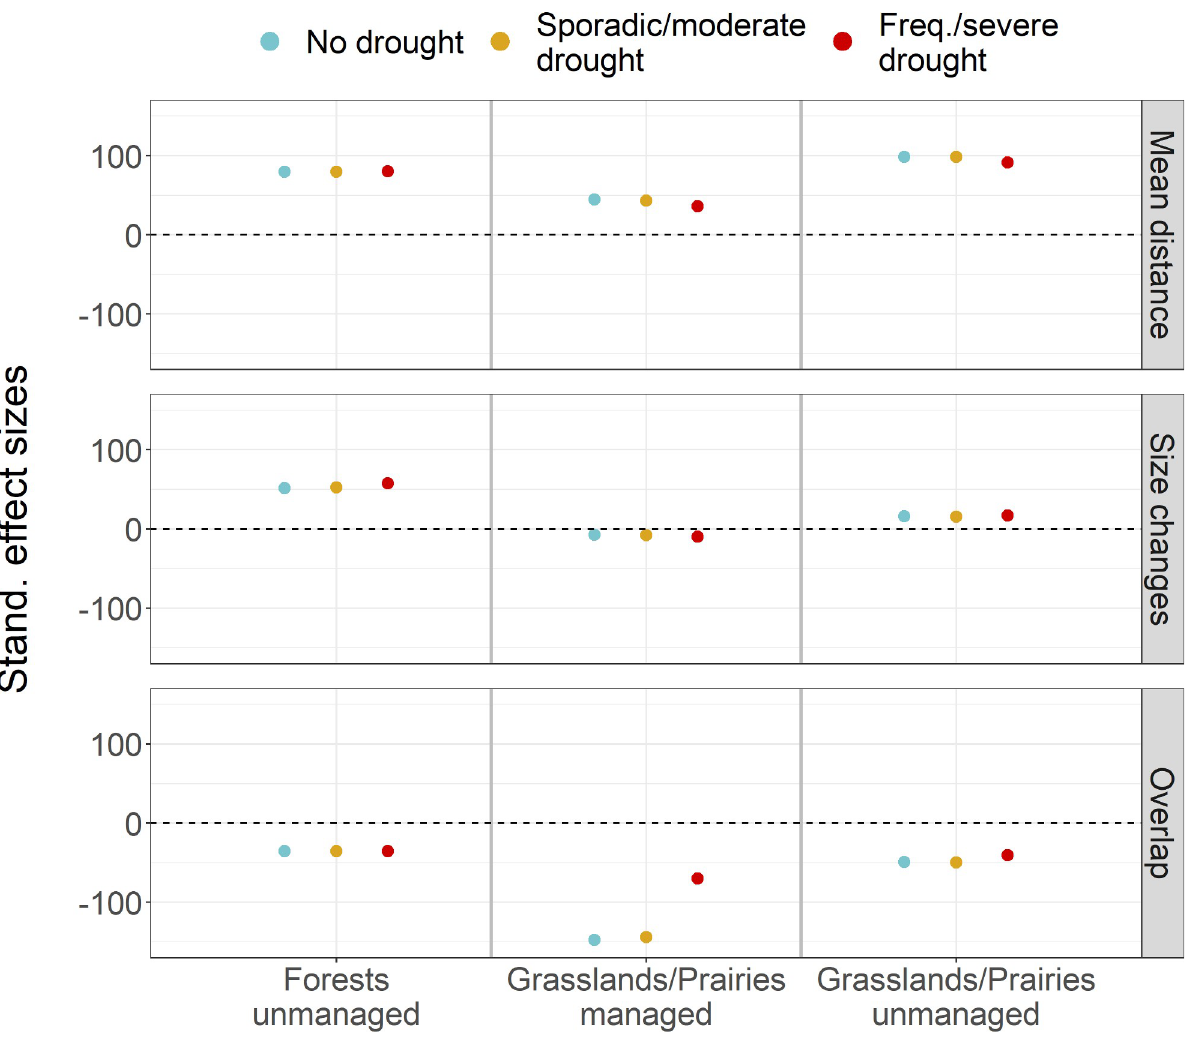
Fig 2. Standardised effect sizes (SESs) of drought scenarios by community and management types on hypervolume metrics, relatively to null comparisons. Dashed lines indicate a zero or no effect. SESs were calculated following Glass’s delta formula, as the mean difference between the scenario and null groups, divided by the standard deviation of the null group